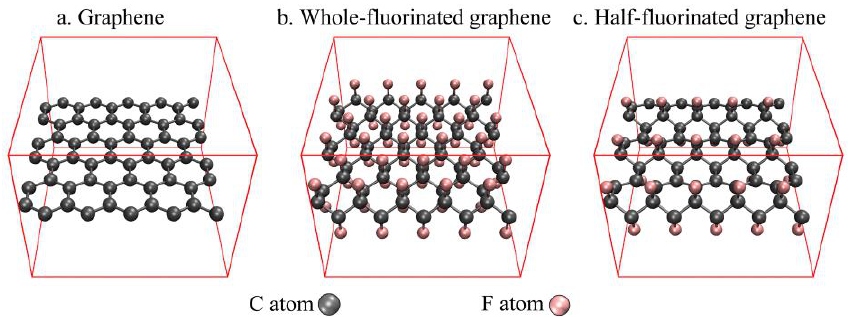
Figure 1. The structures of graphene, whole-fluorinated graphene and half-fluorinated graphene.